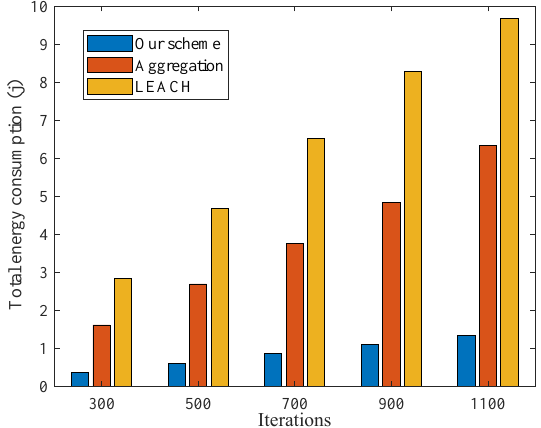
Figure 5. Comparative analysis for energy